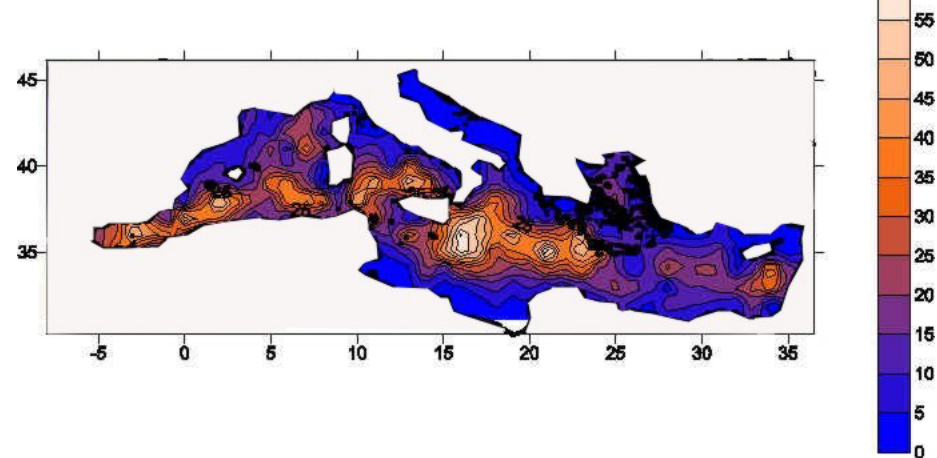
Fig. 2. Spatial distribution of historical XBT data in the MedAtlas data set (1994).